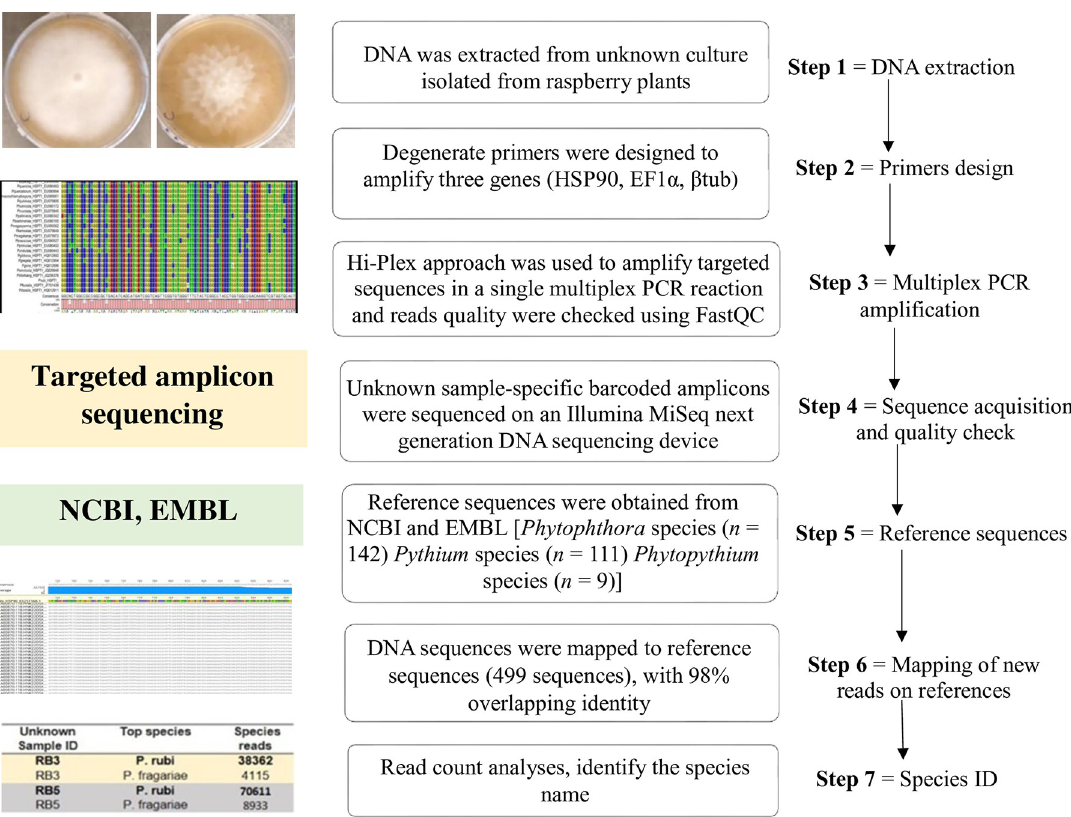
Fig 2. Schematic illustration of the multiplex targeted-sequencing steps used in this study to identify Phytophthora spp. associated with root rot and wilting complex of red raspberry.